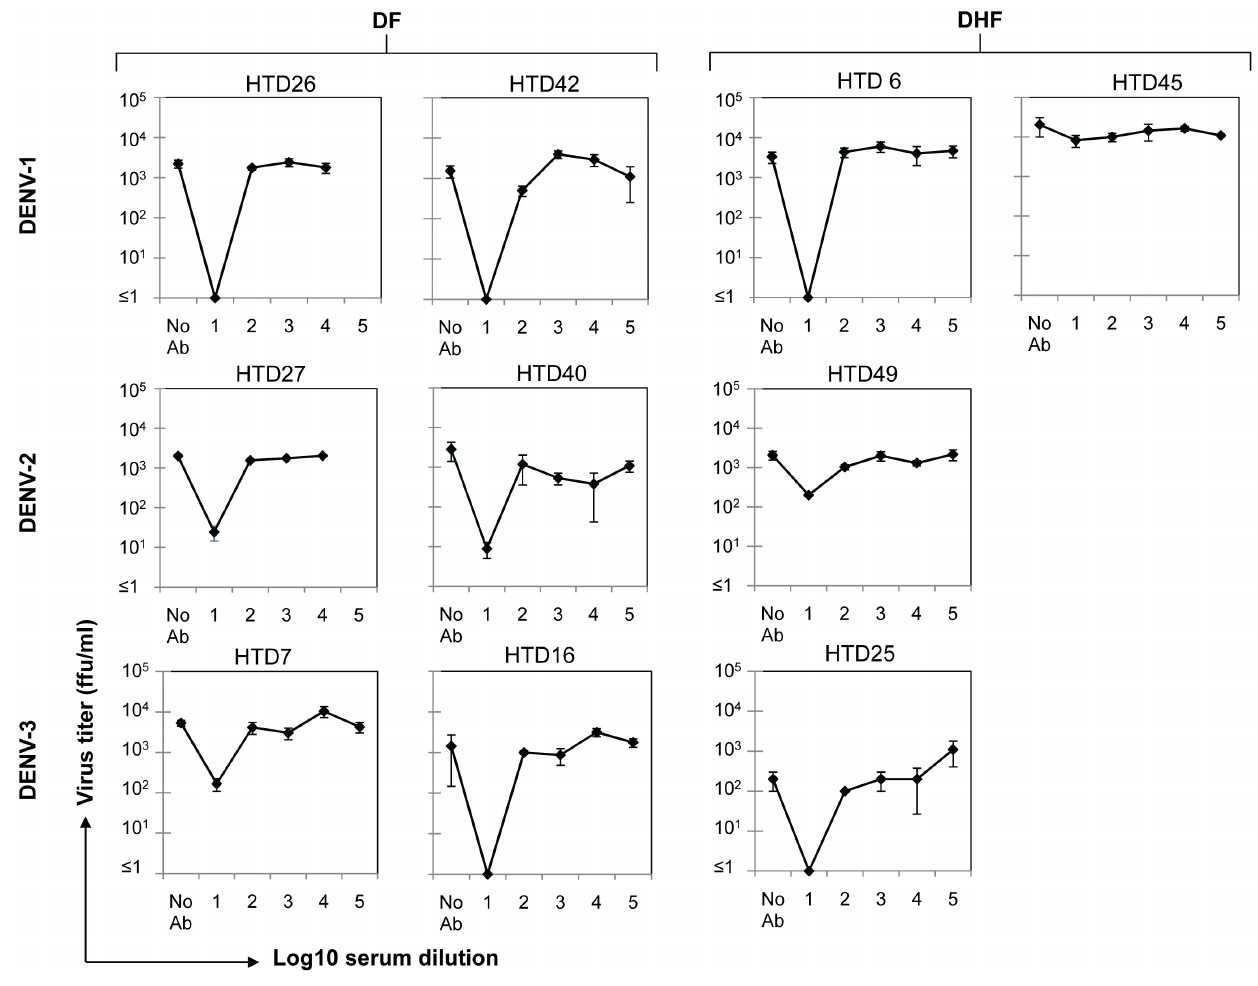
Figure 2. Low ADE when using serum and viruses from DENV-patients. Serum samples (DENV-1, DENV-2, and DENV-3) from HTD dengue patients with DF and DHF symptoms were ultracentrifuged to precipitate DENV virions which were used in assays without any subsequent passage in cells. The supernatant fractions were heat-inactivated at 56 u C for 30 minutes and then serially diluted 10-fold. The dilutions were mixed for 30 minutes at 37 u C with the precipitated virions from autologous plasma at an MOI of 0.02. The virus-antibody complexes were added to K562 cells and incubated for 2 hours at 37 u C before the addition of maintenance medium supplemented with 2% FBS. The cells were then incubated for a further 3 days. Supernatants were harvested for virus titration by focus-forming immunoassay in Vero cells, and the results are expressed as FFU/ml. The mean 6 SD of triplicate experiment is shown. ‘No Ab’ means virus infection in the absence of plasma. The ‘No Ab’ value was used as a baseline for calculating virus infection